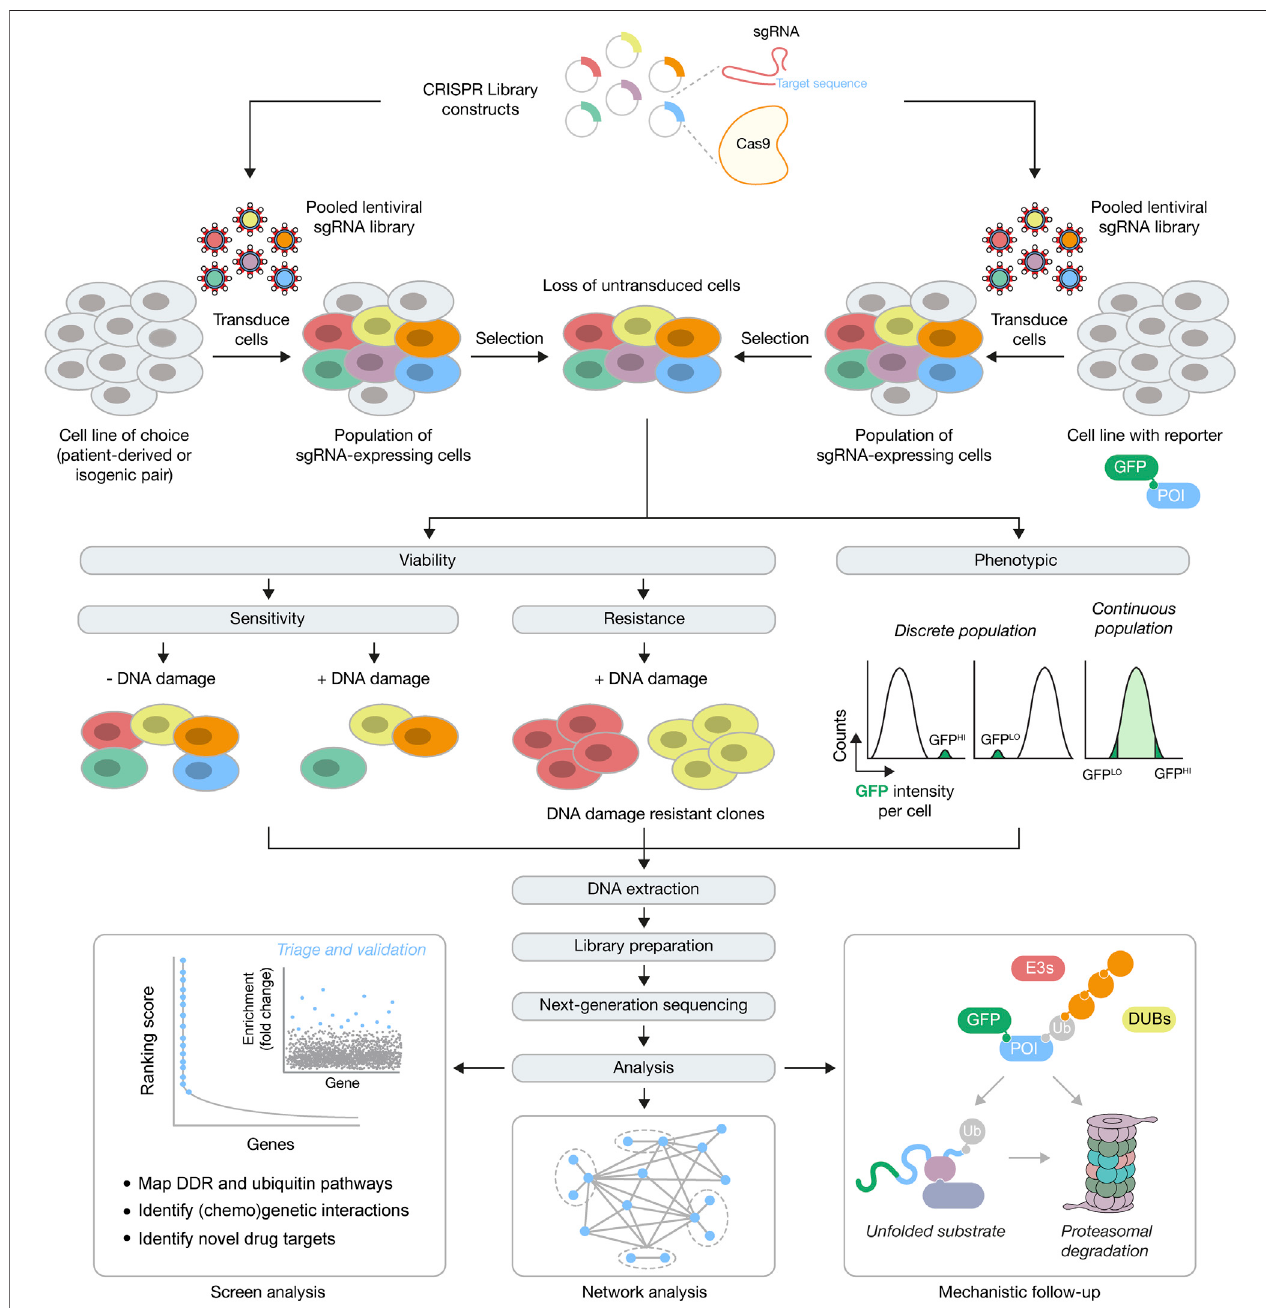
FIGURE 1 | Forward genetics CRISPR-Cas9 screening approaches for the DDR and ubiquitin signaling. Top , for genome-wide screens constructs with Cas9 and sgRNAs against every gene are packaged into lentiviral particles, followed by transduction of cells (typically patient-derived, engineered isogenic pairs or cells with integrated fl uorescent reporters) at low multiplicity of infection, and then selection for stable integrants. POI, protein of interest. Middle , cells with stably integrated constructsexpressingCas9maynowbeusedinanassay-dependentmanner,inviabilityorphenotypicscreens.Forviabilityscreens,negativeorpositiveselection canbeused toidentifygeneswhosefunctionisessentialforsurvival(e.g.,inresponse toDNAdamage)orwhosefunctioncauses aselectiveadvantage(e.g.,resistance in response to DNA damage), respectively. For phenotypic screens, FACS can be used to physically separate the population of cells of choice, depending on the expected population(s) of interest. Bottom , after DNA extraction, library preparation and next-generation sequencing, downstream analysis will identify numerous genetic interactors within a DDR or ubiquitin signaling network, that then undergo triage and further validation. After validation, further investigations are needed to understand the mechanistic basis for the genetic interactions. For example, if components of the UPS (E3s, DUBs, protein quality control components and the and proteasome) are found to regulate the GFP-POI, subsequent work will be required to understand the mechanism of this regulation.